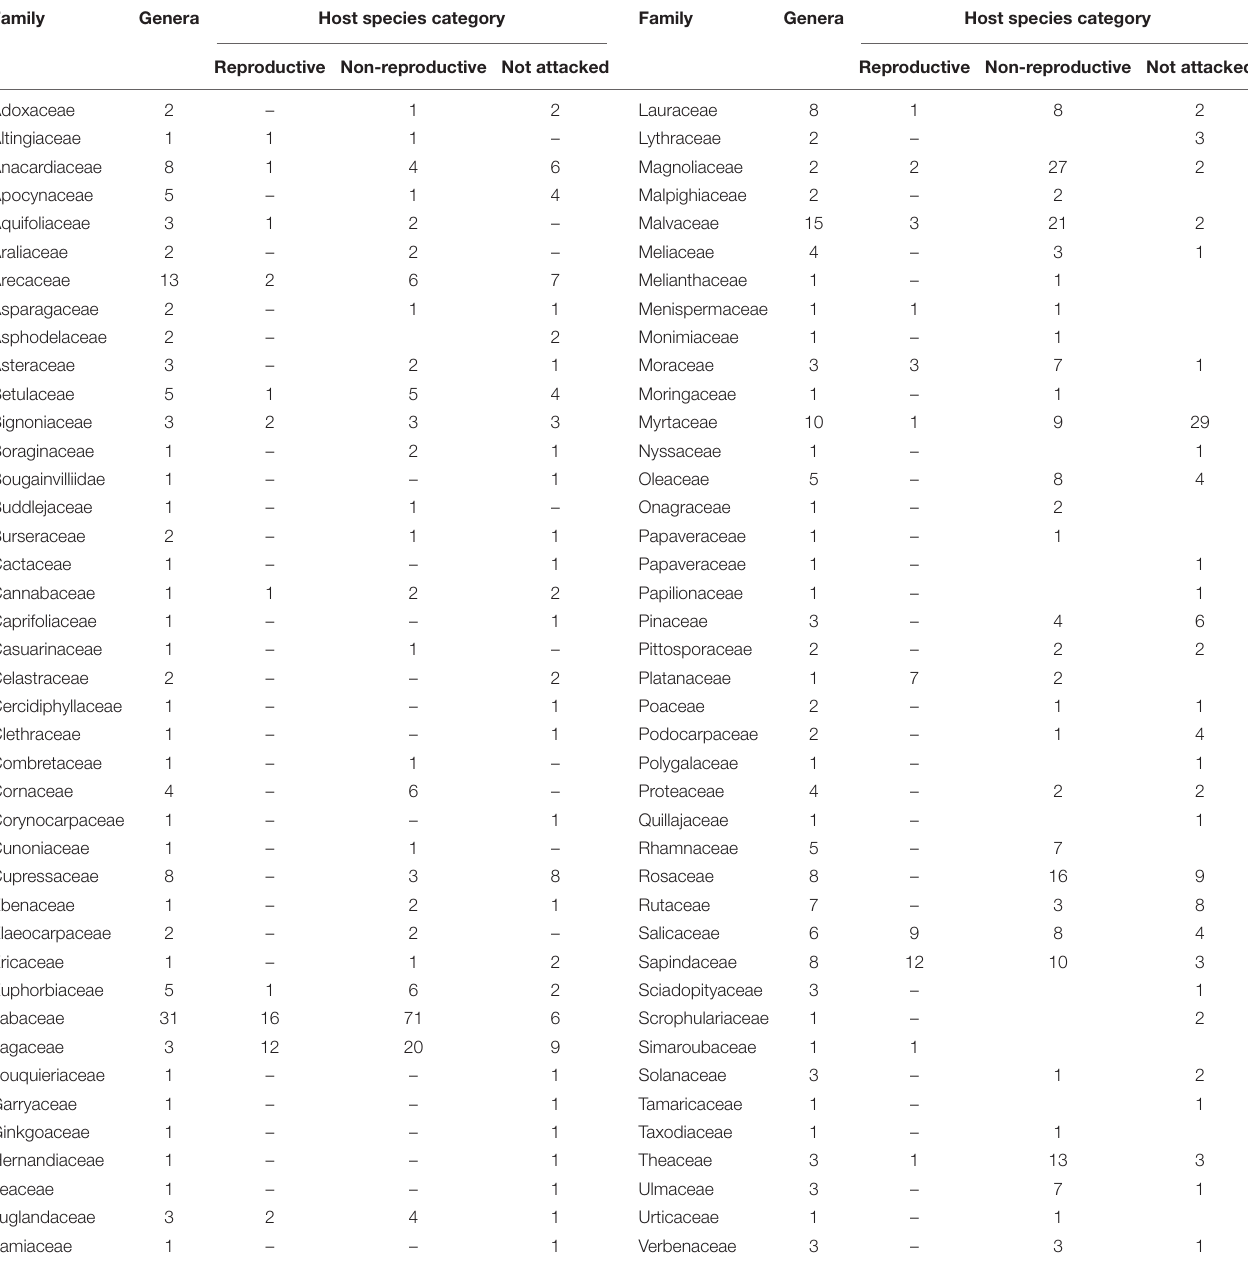
TABLE 2 | Families studied with respect to number of genera and related host species information according to the three categories of susceptibility to the PSHB.